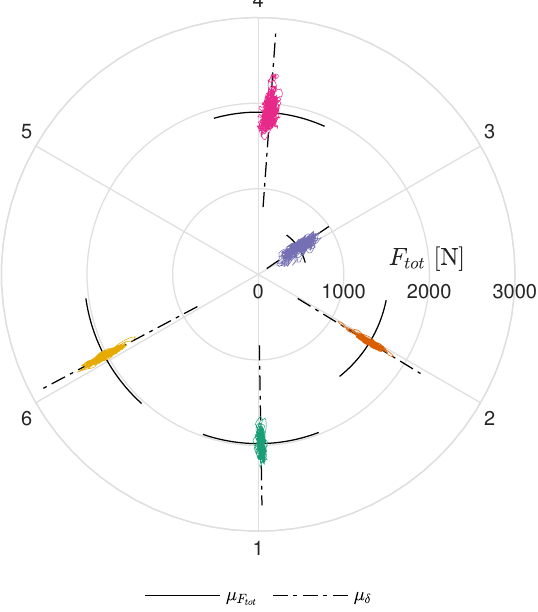
Figure 12: Plot showing forces F tot on panel 145 carrying strain rollers, together with the mean force µ F shown.